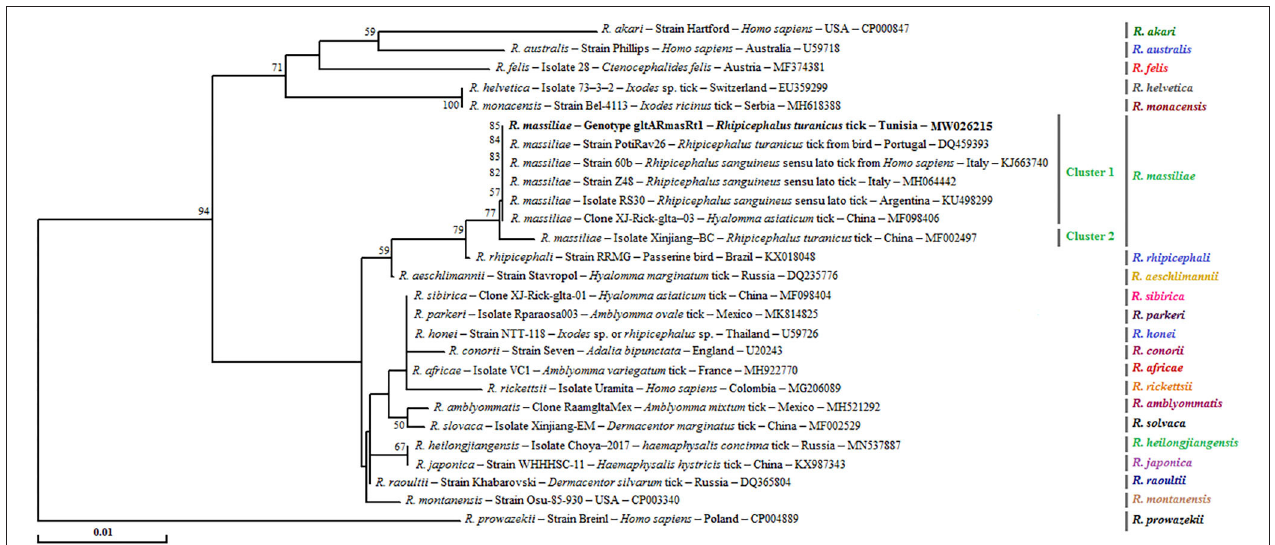
FIGURE 4 | Phylogenetical relationships based on nucleotide multiple alignments of partial Rickettsia spp. gltA sequences (341 bp). Numbers over the branches indicate the percentage of replicated trees in which the associated taxa clustered together in the bootstrap test (1,000 replicates, only percentages > 50% were represented). The only R. massiliae gltA genotype revealed in this study from 25 positive samples is represented in bold. The host or vector, the genotype, sequence type, strain or isolate name, the country of origin, and the GenBank accession number are indicated. One R. prowazekii gltA partial sequence was added as an